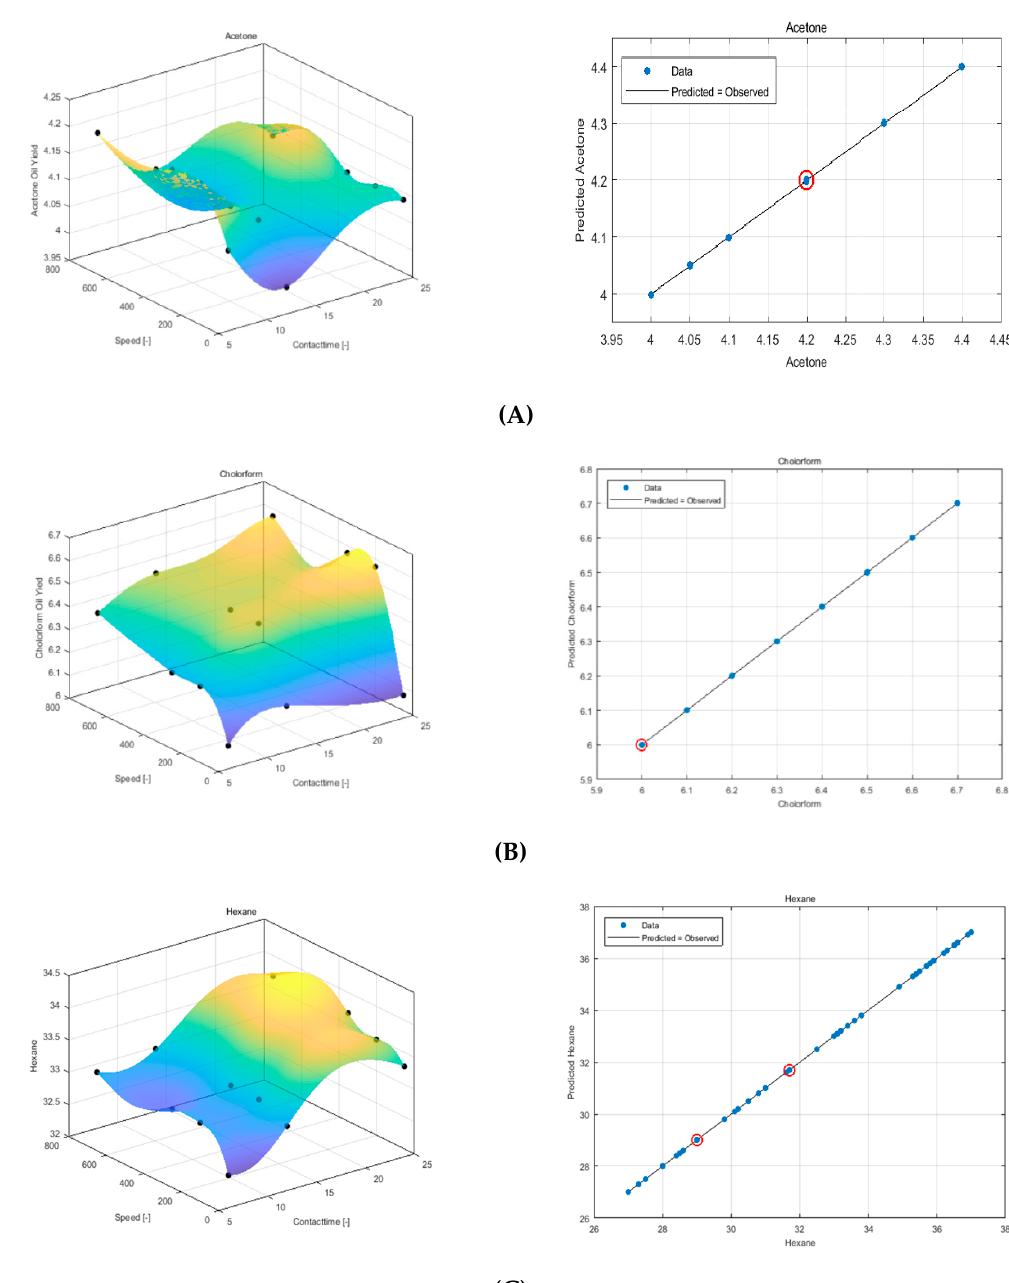
Figure 5. Response surface plot using ANN and experimental versus predicted data for sesame seed oil extraction using ( A ) acetone, ( B ) chloroform, and ( C ) hexane.